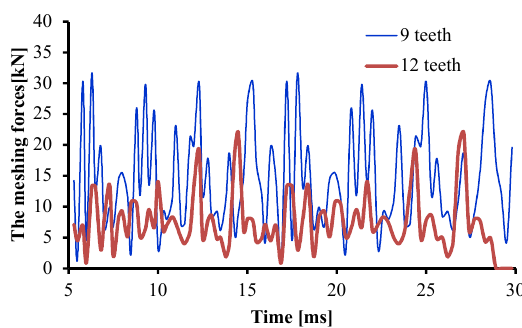
Figure 11. The meshing forces of the gear pump.